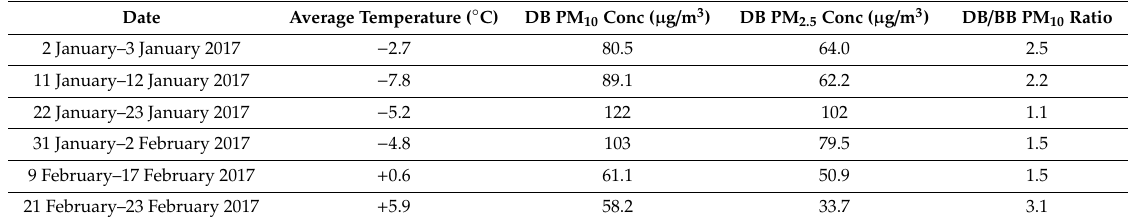
Figure 2. Daily average PM 10 and PM 2.5 concentrations observed at the urban sampling site DB, and daily average PM 10 concentrations observed at the reference site Bockberg (BB). The grey shaded area presents the PM 10 ratio between DB and BB. For convenient reference, the red line marks the 50 µ g / m 3 limit value set by the European Commission. Table 1. Average temperature, average PM 10 and PM 2.5 concentrations ( µ g / m 3 ) at site DB, and PM 10 urban / background ratio for time periods representing scenario 1 and